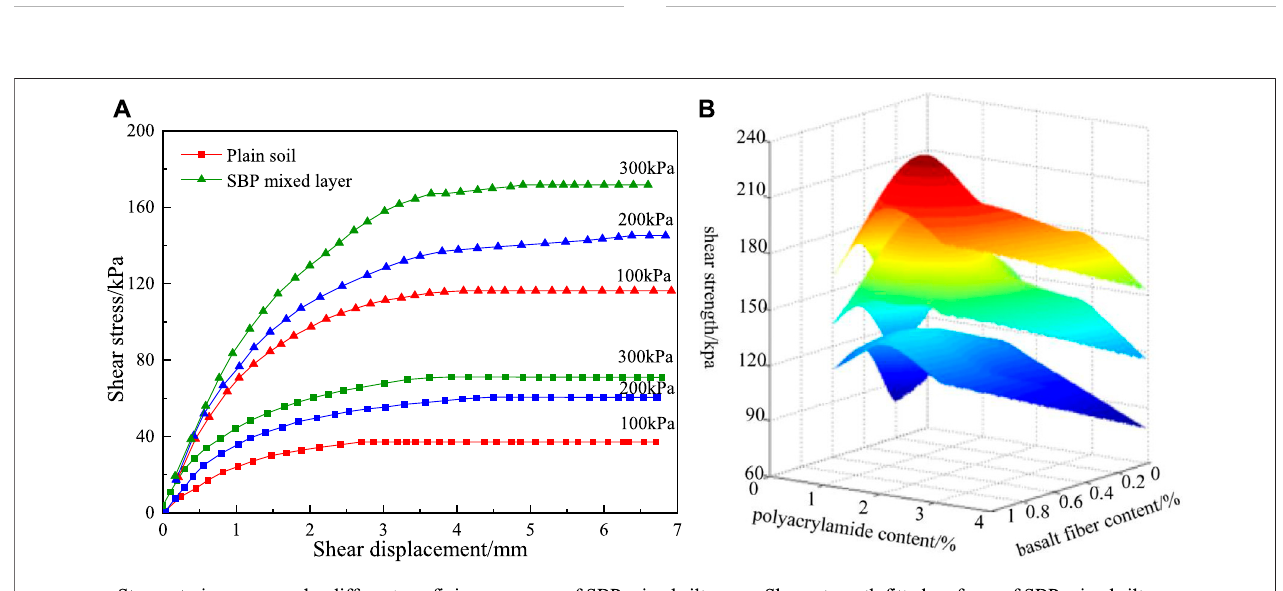
FIGURE7| Stress-straincurvesunderdifferentcon fi ningpressuresofSBPmixedsilt. (A) Stress-straincurvesunderdifferentcon fi ningpressuresofSBPmixedsilt (B) Shear strength fi tted surfaces of SBP mixed silt